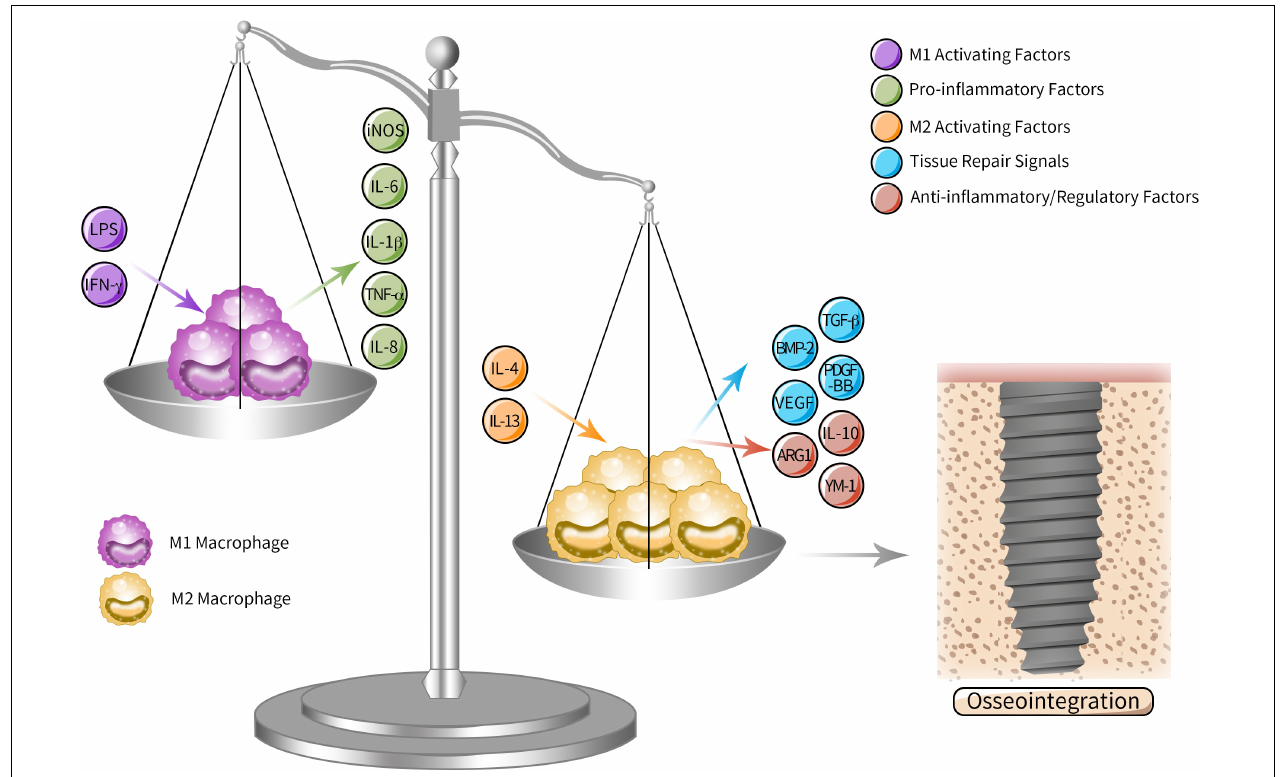
FIGURE 2 | M1/M2 polarization spectrum in osteoimmunology mediated osseointegration. As the key participants in peri-implant osteoimmunology, macrophages can be subdivided into M1 and M2 according to the activation pathway, secretion and function. M1 is the pro-inflammatory type activated by M1 activating factors such as LPS and IFN- γ , inducing excessive fibrosis and osseointegration failure by secreting pro-inflammatory cytokines, while M2 is activated by M2 activating factors such as IL-4 and IL-13, which promote osseointegration through anti-inflammatory and regulatory cytokines. Although in vivo macrophages actually display an intermediate state along the polarization spectrum, tipping the polarizing “scale” of macrophage from M1 to M2 leads to influencing microenvironment of inflammation and regeneration around implants and promoting